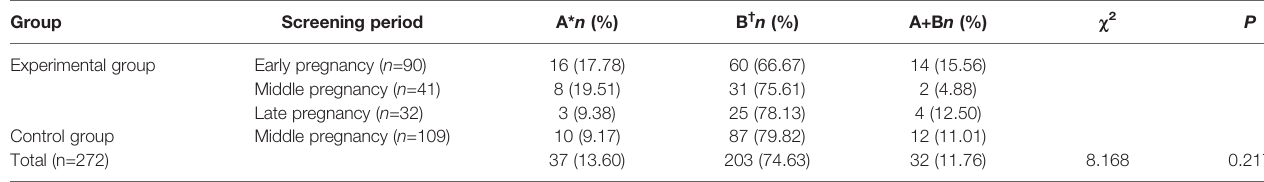
TABLE 2 | Diagnostic basis of HIP diagnosis in different screening